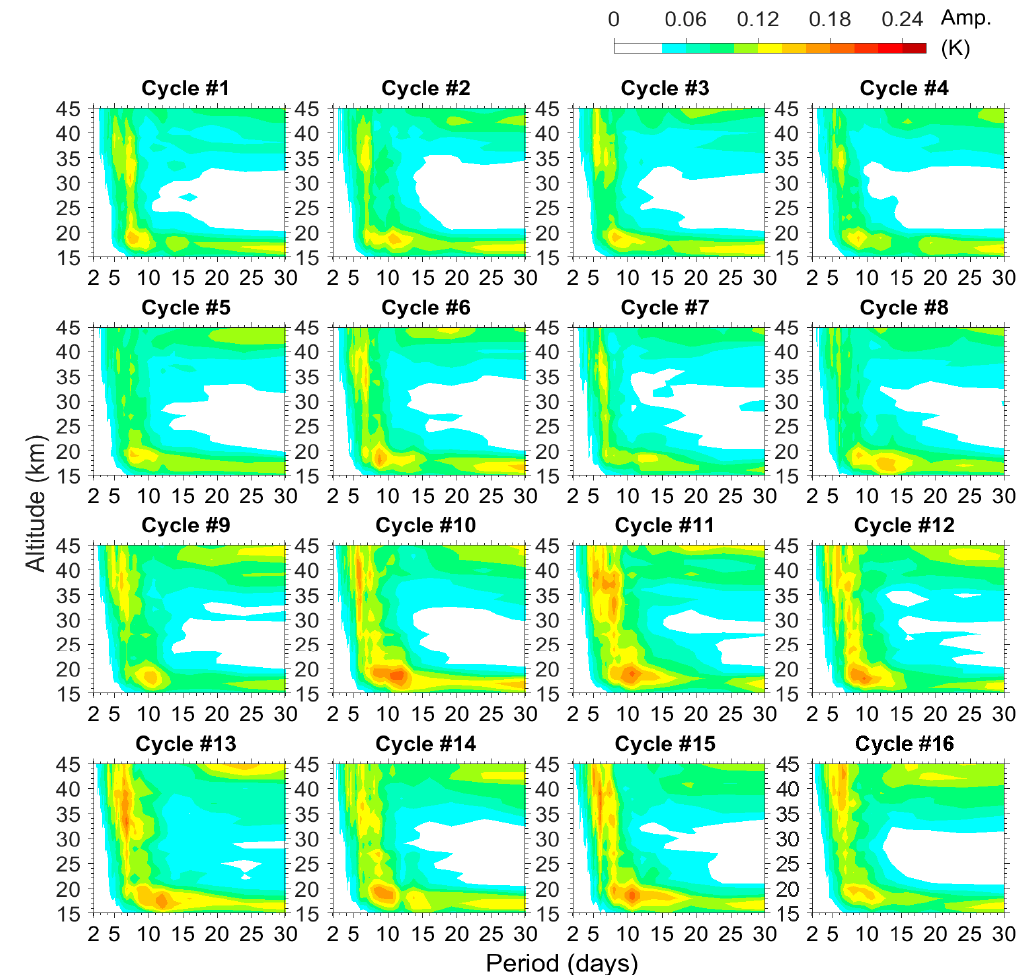
Figure 4. Same as in Figure 2, but showing the amplitudes of wavenumber 2 (E2) waves with a different color axis scaling.